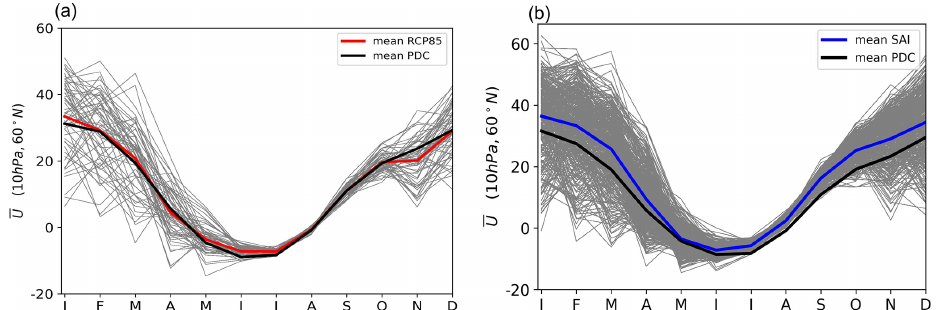
Figure 12. Monthly mean evolution of the zonal-mean zonal wind at 10hPa and 60 ◦ N for the RCP8.5 (a) and SAI (b) simulations. The zonal winds for each year for the RCP8.5 and SAI scenarios are shown by the gray lines, and the multi-ensemble multi-year averages are shown by the red and blue lines for RCP8.5 and SAI, respectively. The black line indicates the multi-ensemble multi-year average of the PDC